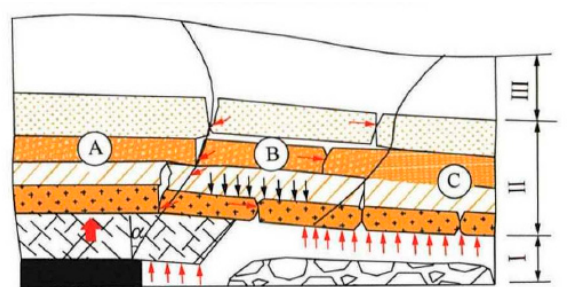
Figure 1. Movement division of overlying strata. I: caving zone; II: fractured zone; III: curved subsidence zone [2].